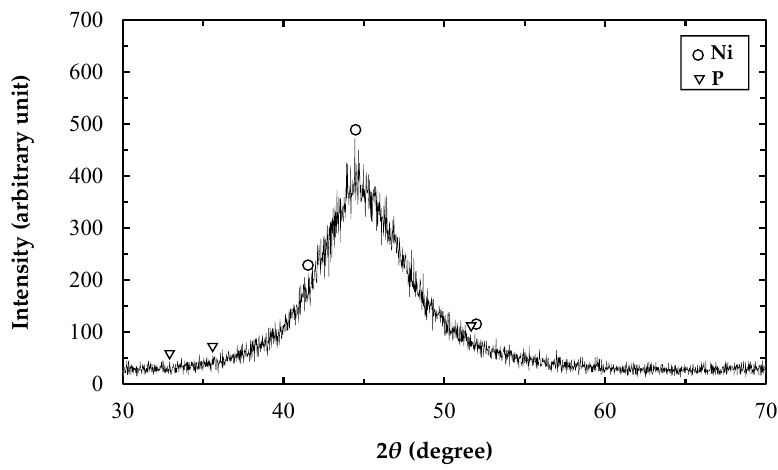
Figure 4. XRD diffraction patterns of Ni-11P plated layer.